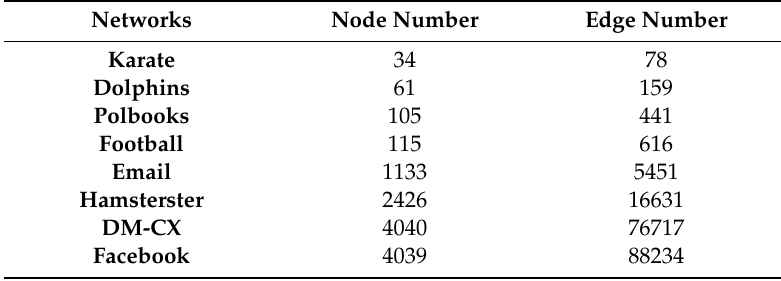
Table 2. Real-world network